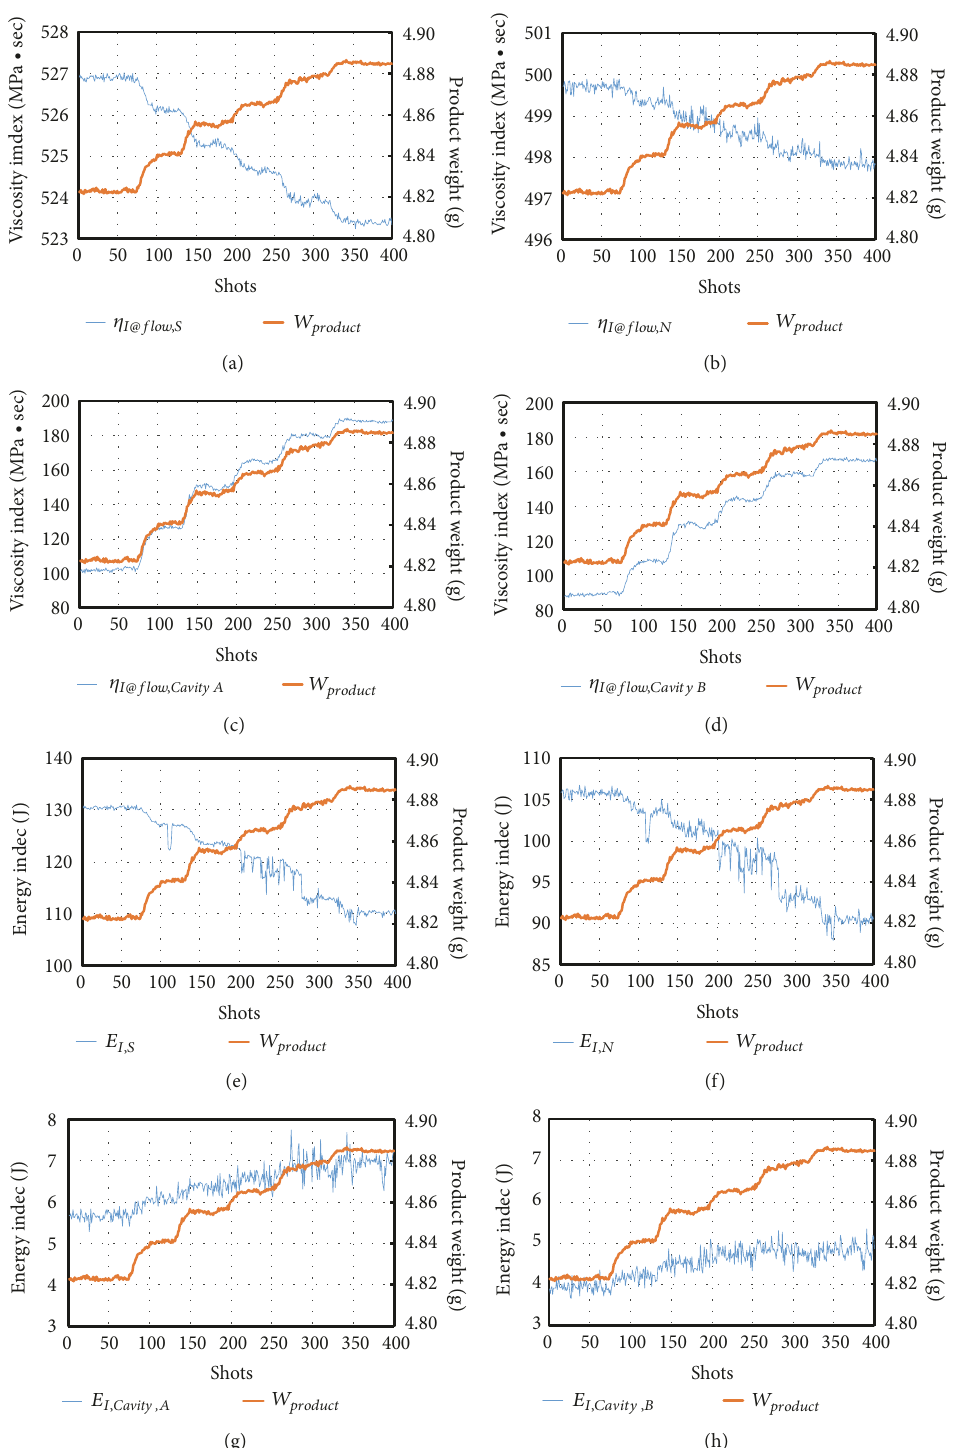
Figure 17: Melt quality fluctuation as revealed by viscosity and energy quality